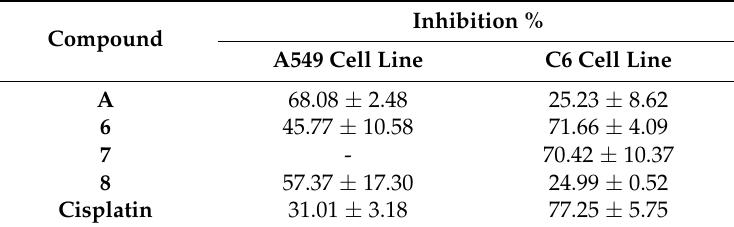
Table 4. Akt inhibitory effects of compounds A, 6, 7 and 8